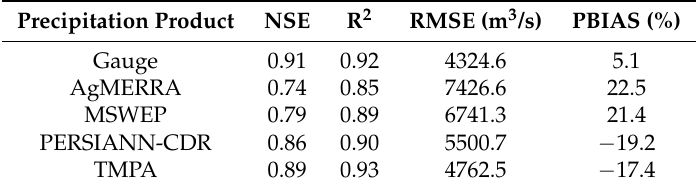
Table 9. Comparison of daily-observed streamflow and simulated streamflow with fixed hydrological parameters for